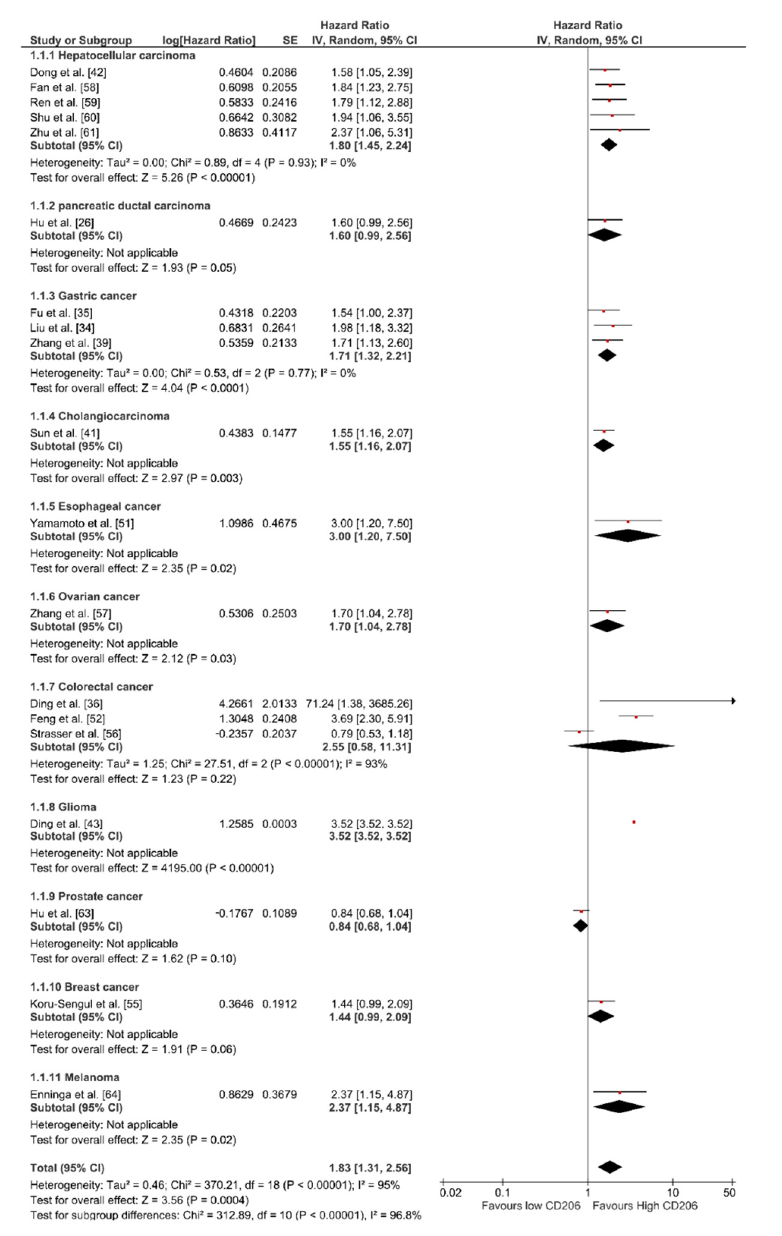
Figure A1. Forrest plot of impact of CD206-expression on overall survival of patients diagnosed with solid cancers. SE: standard error; IV: Interval variable; CI: confidence interval; df: degrees of freedom.